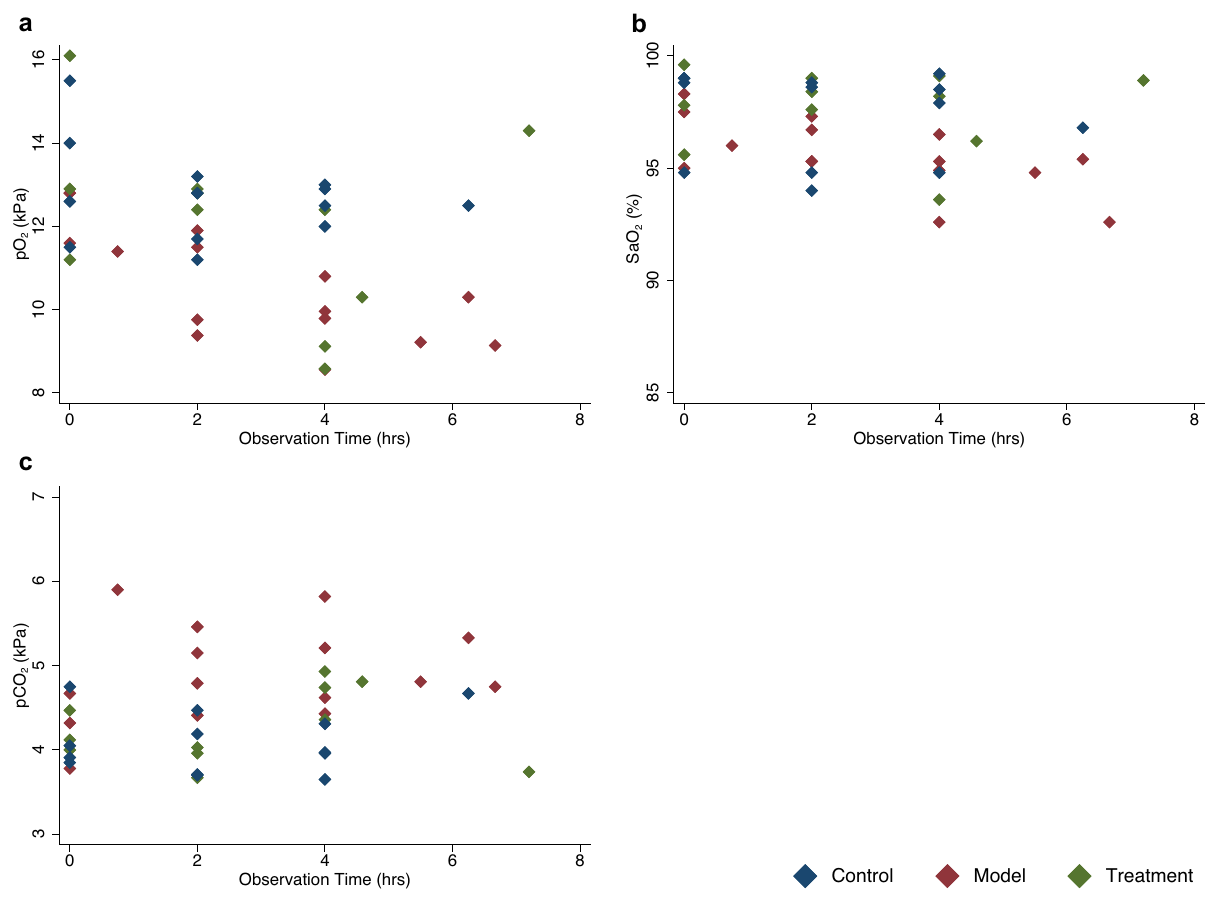
Fig. 5 Individual blood gas analysis in arterial blood across time. a Partial pressure of oxygen. b Blood oxygen saturation. c Partial pressure of carbon dioxide. Red diamonds represent model individuals, blue control individuals, and green treatment individuals. Source data are provided as source data fi le.